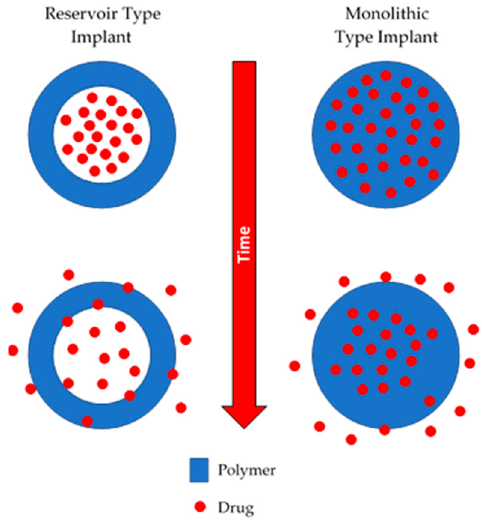
Figure 1. An illustration of reservoir and monolithic type implants.